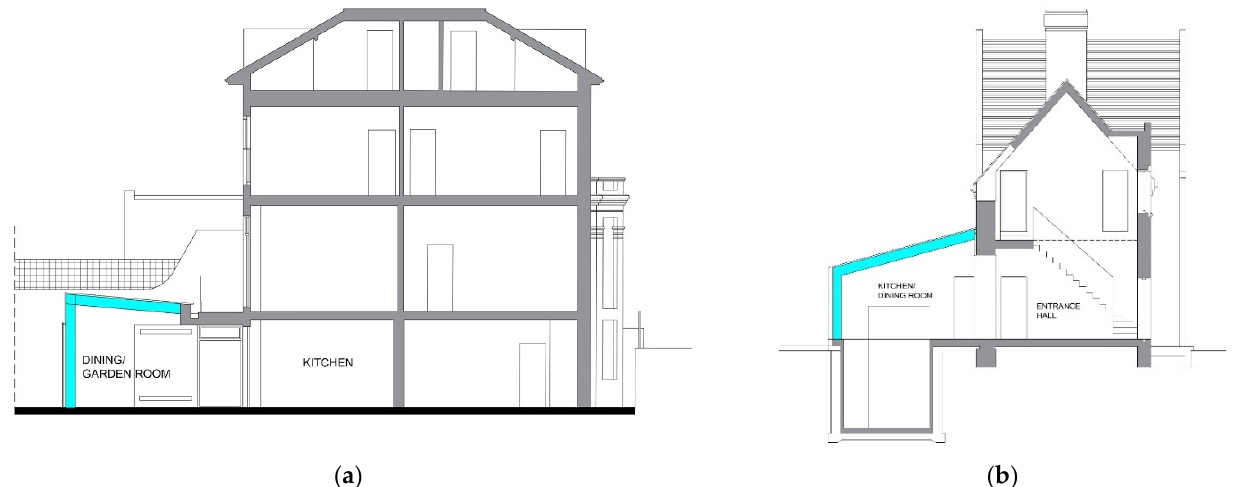
Figure 7. Extension in houses: ( a ) house at Castelnau in London (developed by the author based on the architect’s drawings); ( b ) house at Milnthorpe Corner in Winchester (developed by the author based on the architect’s drawings).